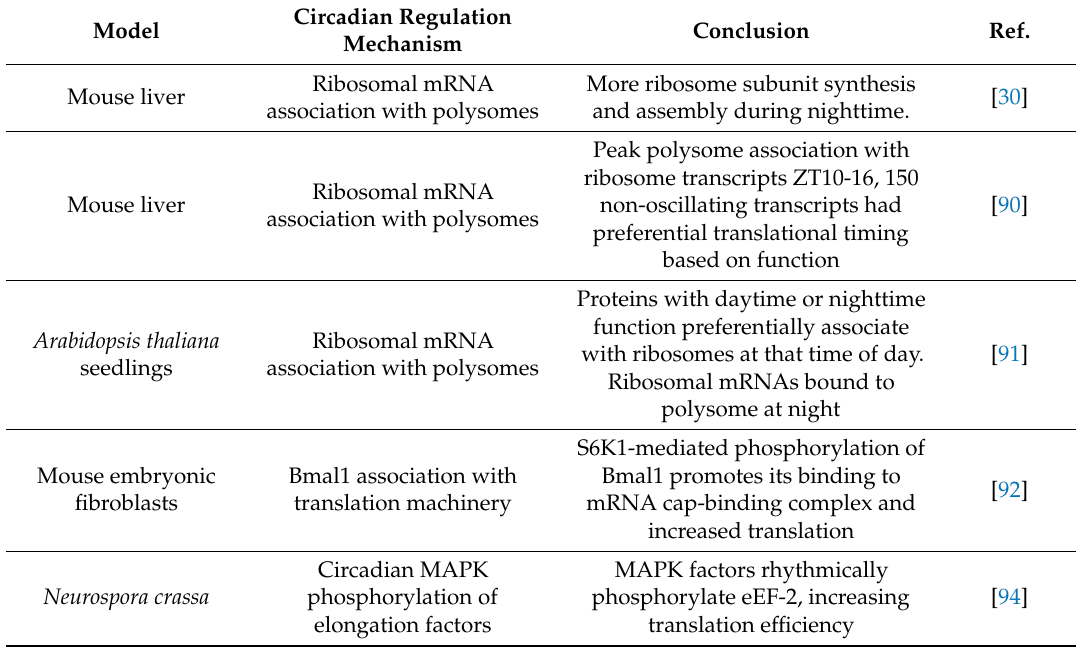
Table 4. Circadian regulation of translational